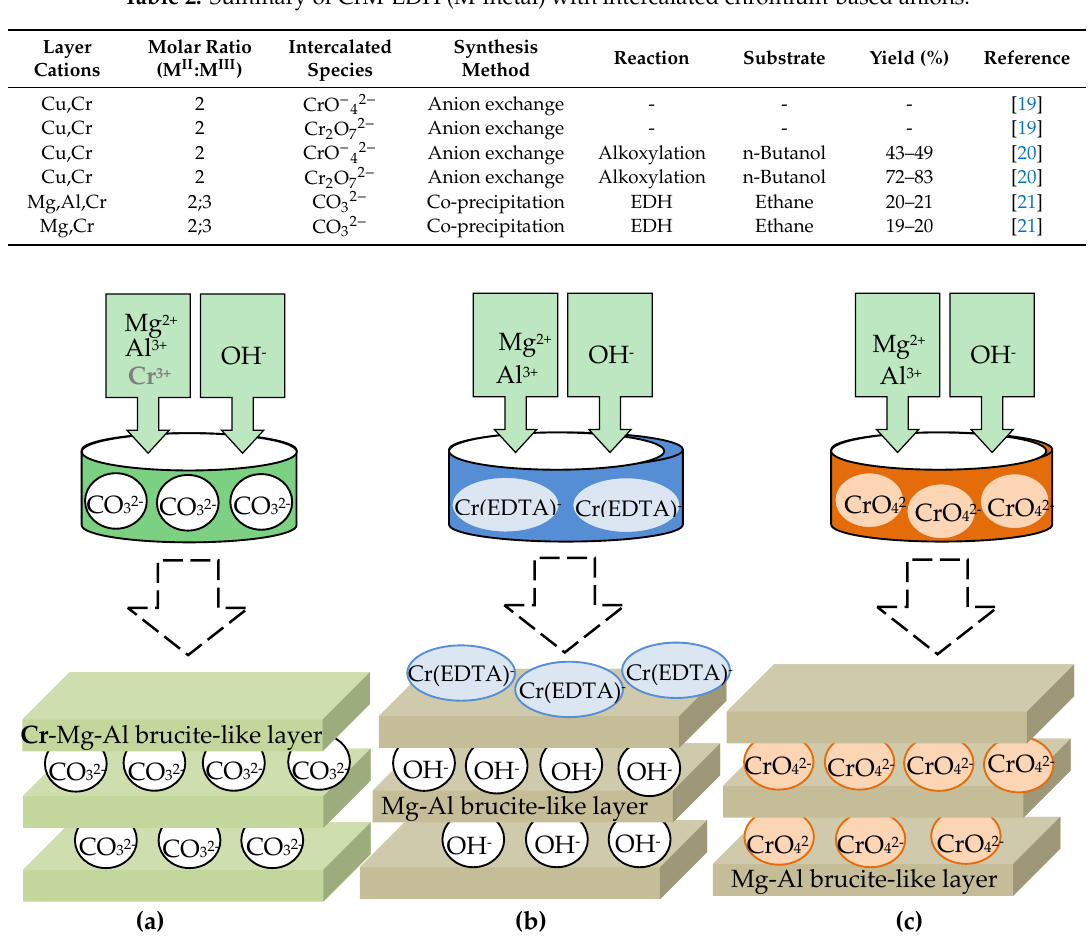
Table 2. Summary of CrM-LDH (M-metal) with intercalated chromium-based anions.